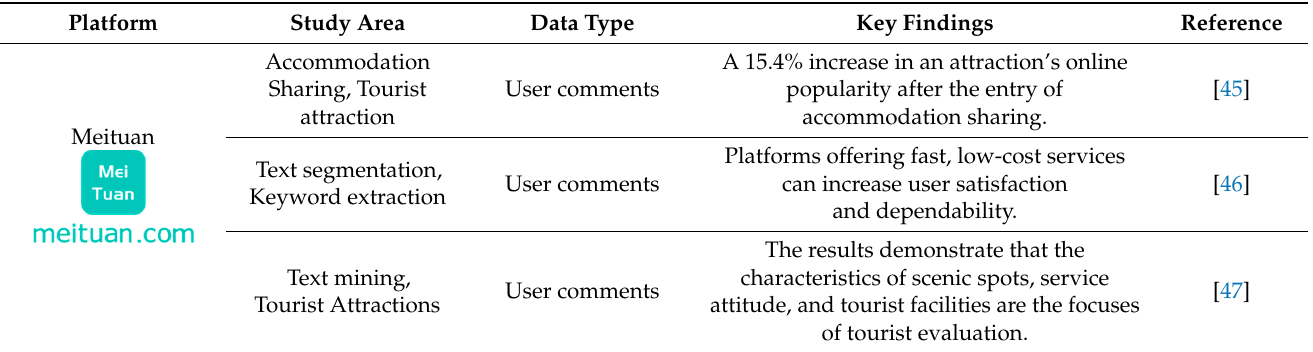
Table 1. The application of the four platforms in related research.